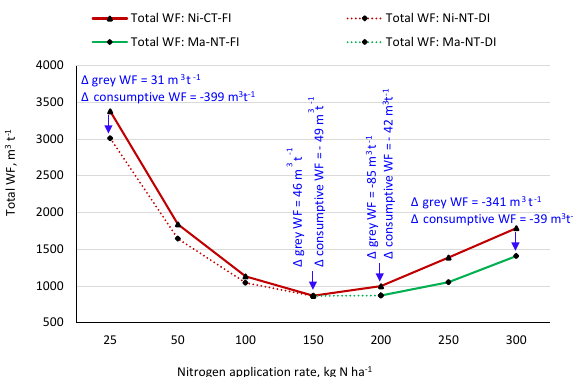
Figure 6. The total (green, blue and grey) WF per tonne for the reference management package and for a management package with the largest total WF reduction potential. Red lines refer to ni- trate (Ni); green lines refer to manure (Ma). Circular markers refer to no-tillage (NT); triangular markers refer to conventional tillage. Dashed lines refer to deficit irrigation (DI); solid lines refer to full irrigation (FI).